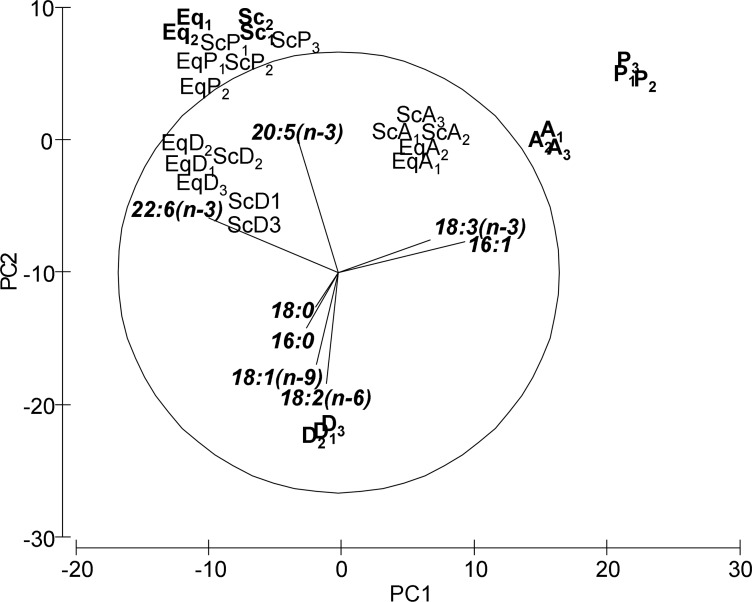
Principal Component Analysis (PCA) plot based on the Fatty Acid (FAs) composition.FAs were analysed for the three types of feed used in the experiment as diets (A: Artemia, P: Phytoplankton, D: Detritus), the caprellids (Eq: C. equilibra, Sc: C. scaura) collected from marinas (used as reference values) and the caprellids fed either Artemia, phytoplankton or detritus for 12 days under laboratory conditions (EqA, EqP, EqD, ScA, ScP, ScD). Subscript numbers (1,2,3) correspond to each replicate value. Replicates Eq3, EqA3, EqP3 and Sc3 are not included since they were damaged during the chemical procedure and lost. For PERMANOVA analyses, the values of these replicates were filled with the mean values of the other two remaining replicates.